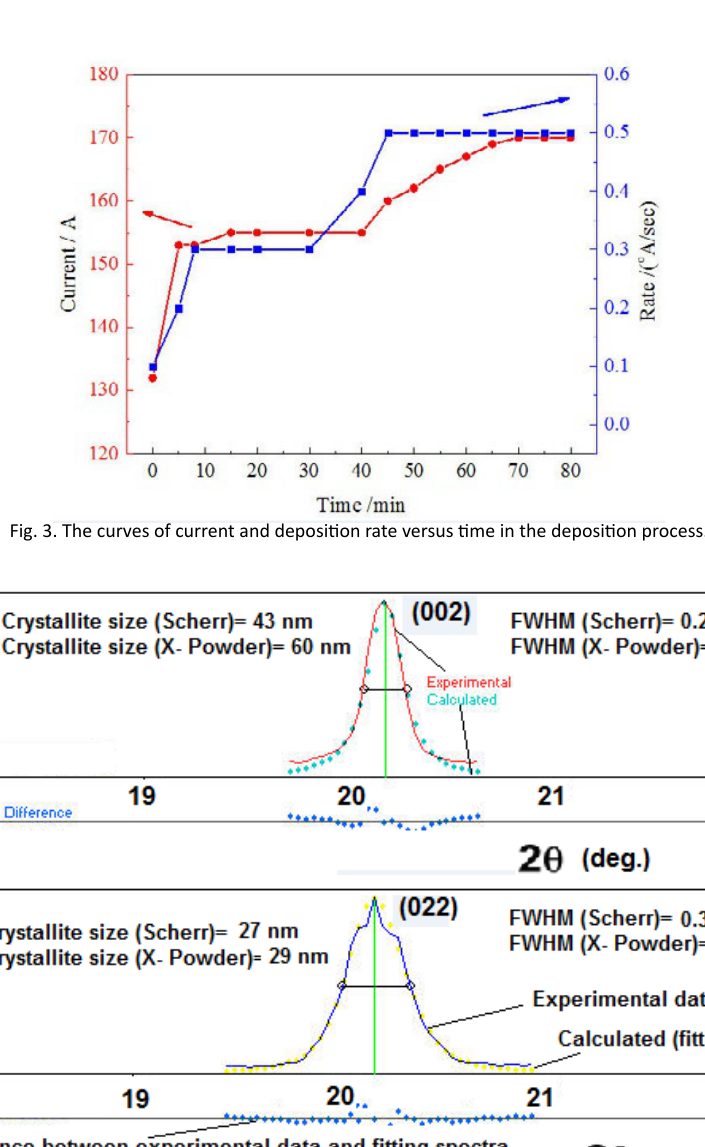
crystallite phase 3